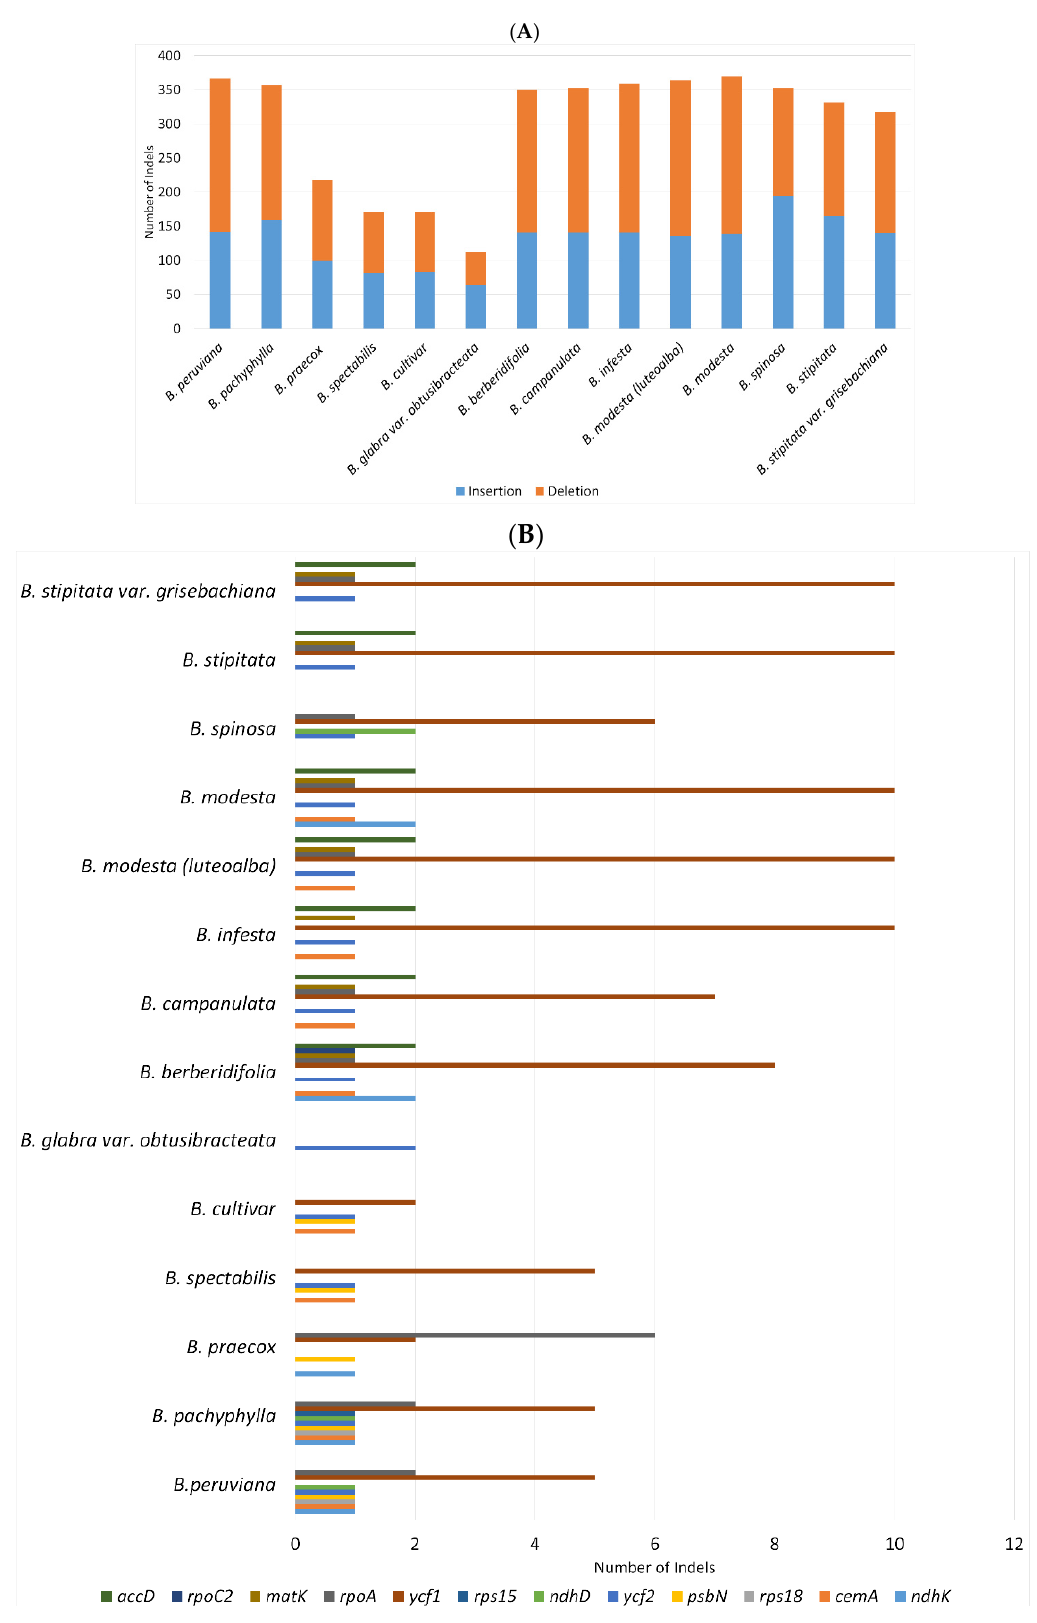
Figure 3. Total number of indels found in plastid genomes of Bougainvillea . ( A ) Number of indels observed in coding and non-coding sequences. ( B ) Coding genes with greatest occurrence of insertions and deletions.